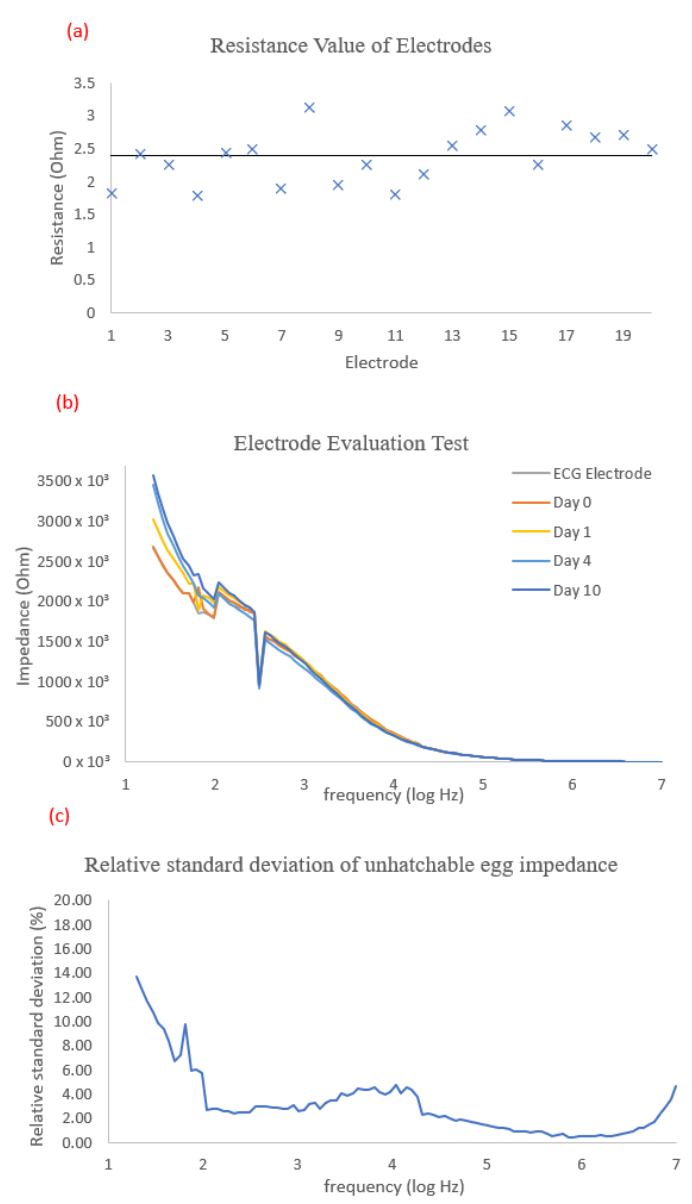
Figure 5. ( a ) Electrodes’ resistance validation (each sign represent the value of one electrode). ( b ) Impedance data of an unfertilized egg at different days with ( c ) relative standard